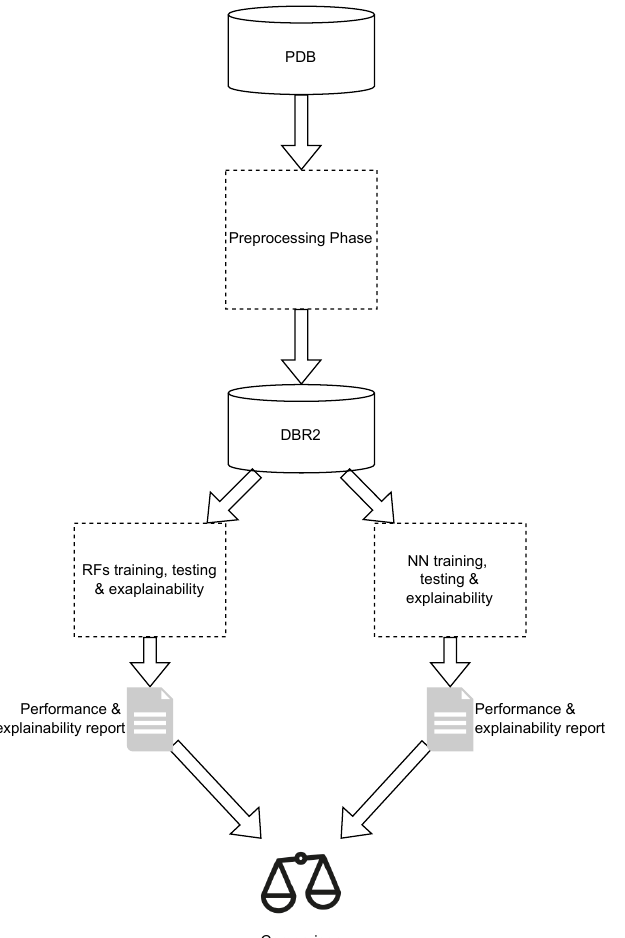
Figure 1 sketches the schema of the methodology followed.